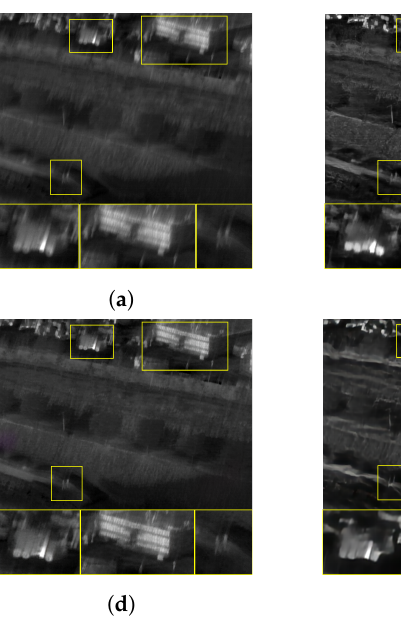
Figure 18. Qualitative comparison of motion deblurring results on the real blurry thermal